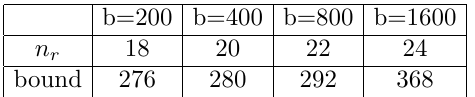
Table 4: Bounds on the weight of trails over the total number of